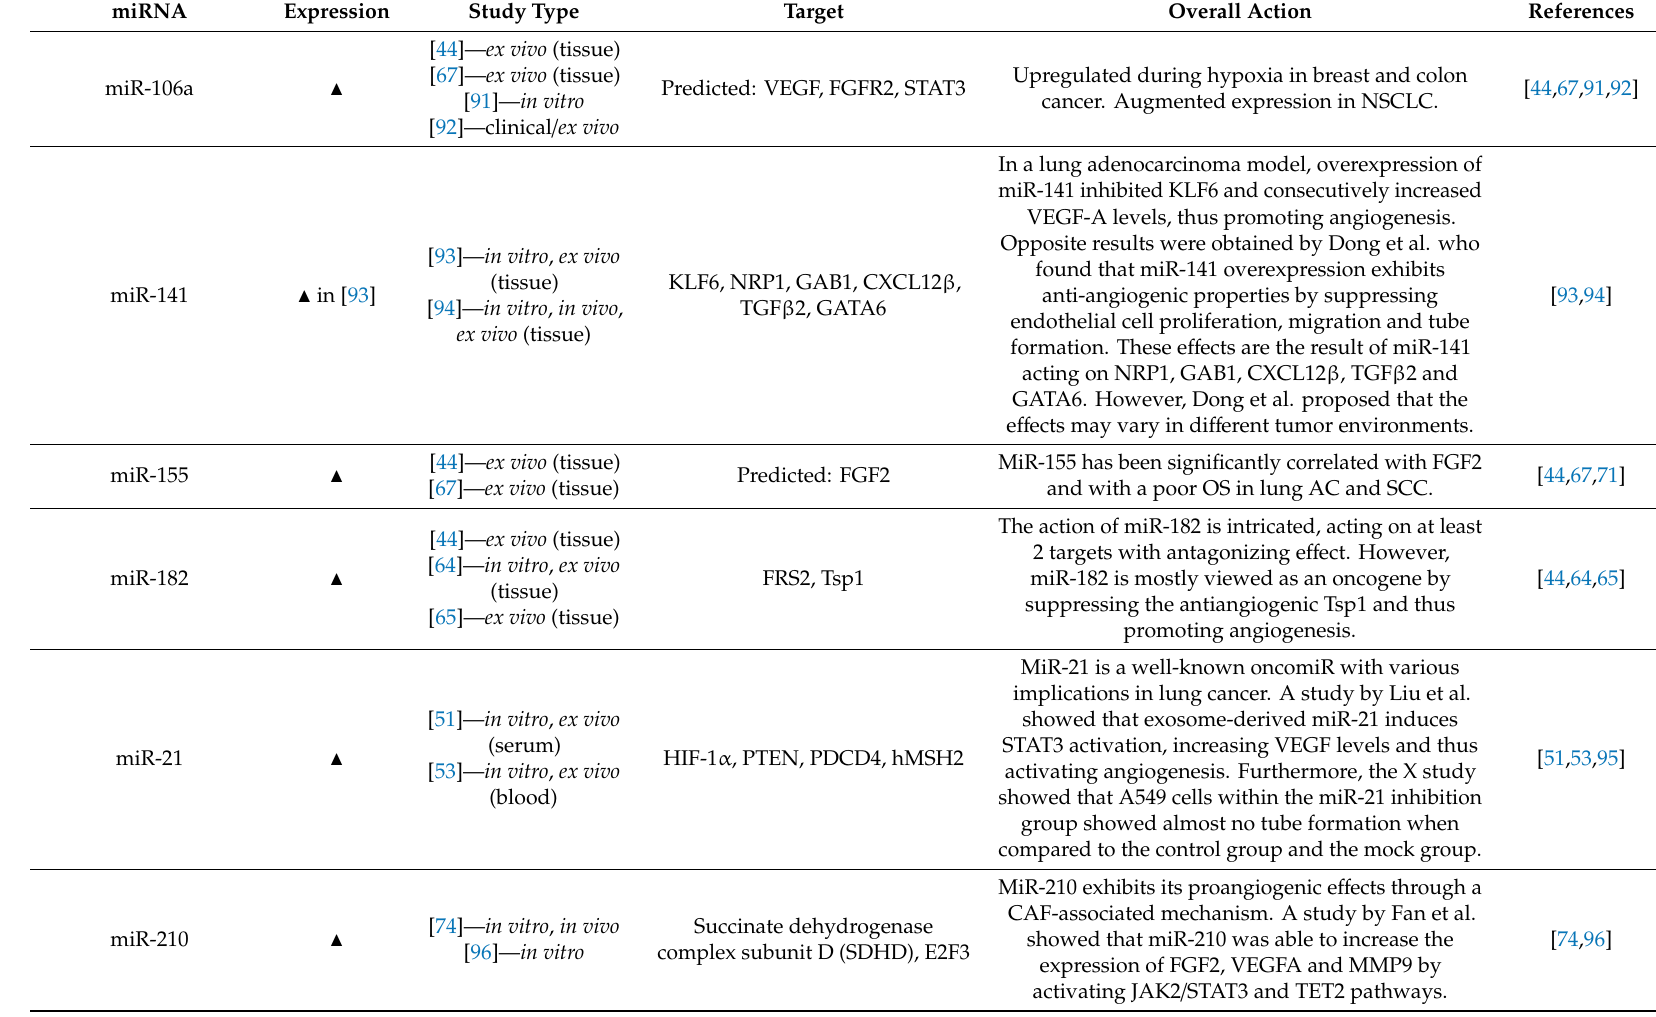
Table 2. miRNAs with regulatory potential in lung